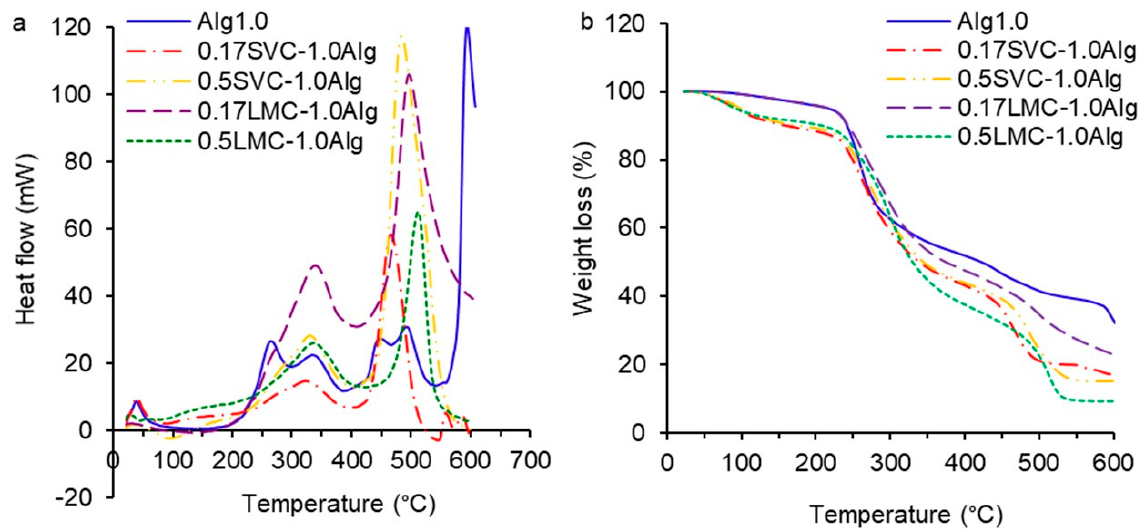
Figure 5. DSC ( a ) and TGA ( b ) thermograms of GSE-loaded Ca-alginate (Alg1.0) and Alg1.0/callus (0.17SVC-1.0Alg, 0.5SVC-1.0Alg, 0.17LMC-1.0Alg, 0.5LMC-1.0Alg)